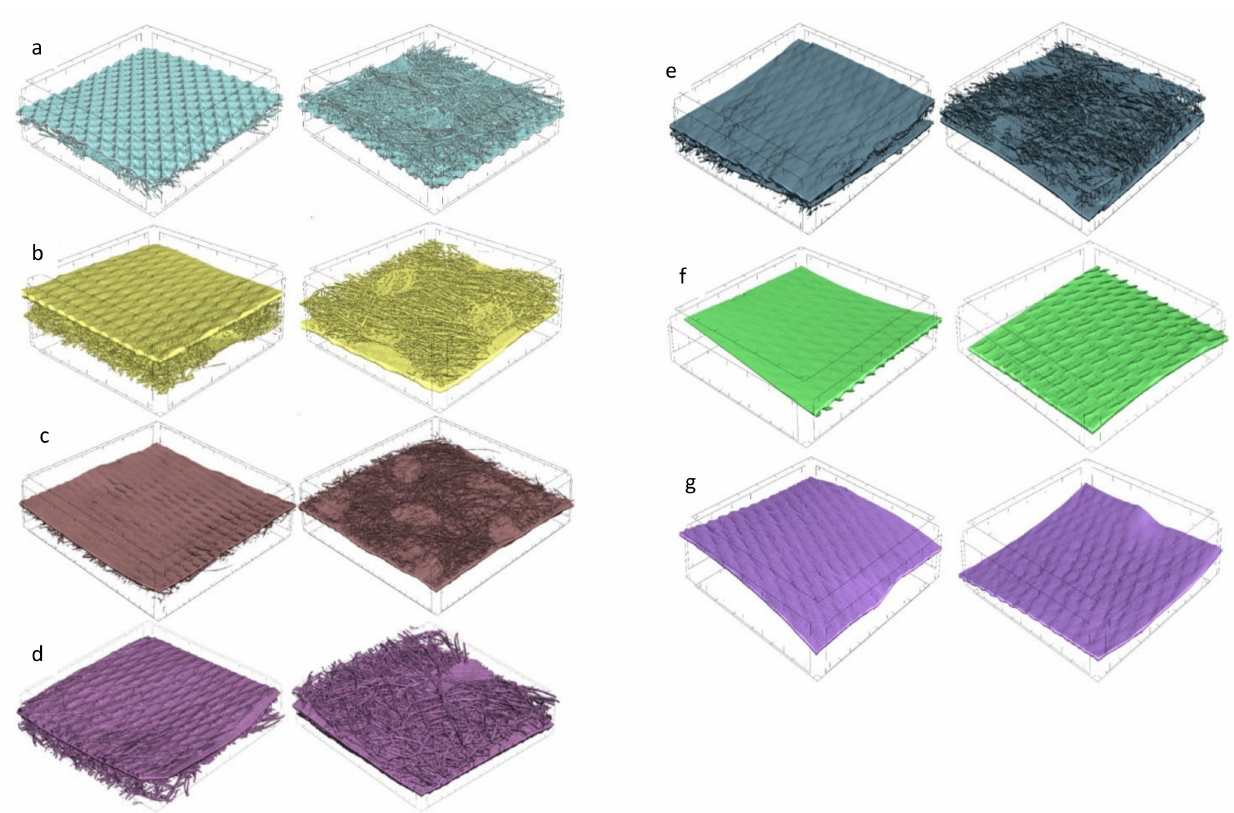
Figure 9. Micro-CT 3D reconstructions of tested textiles (all textiles have an area of 1 cm × 1 cm). ( a ) Two-layer laminate (24 g · m − 2 PE foil + 16 g · m − 2 PP non-woven); ( b ) Two-layer laminate (30 g · m − 2 PE foil + 35 g · m − 2 PP non-woven); ( c ) Two-layer laminate (15 g · m − 2 PE foil + 12 g · m − 2 PP non- woven); ( d ) Two-layer laminate (15 g · m − 2 PE foil + 15 g · m − 2 PP non-woven); ( e ) Two-layer laminate (15 g · m − 2 PE foil + 10 g · m − 2 PP non-woven); ( f ) Vapor-permeable PE foil 15 g · m − 2 ; and ( g ) Vapor- permeable PE foil 15 g · m − 2